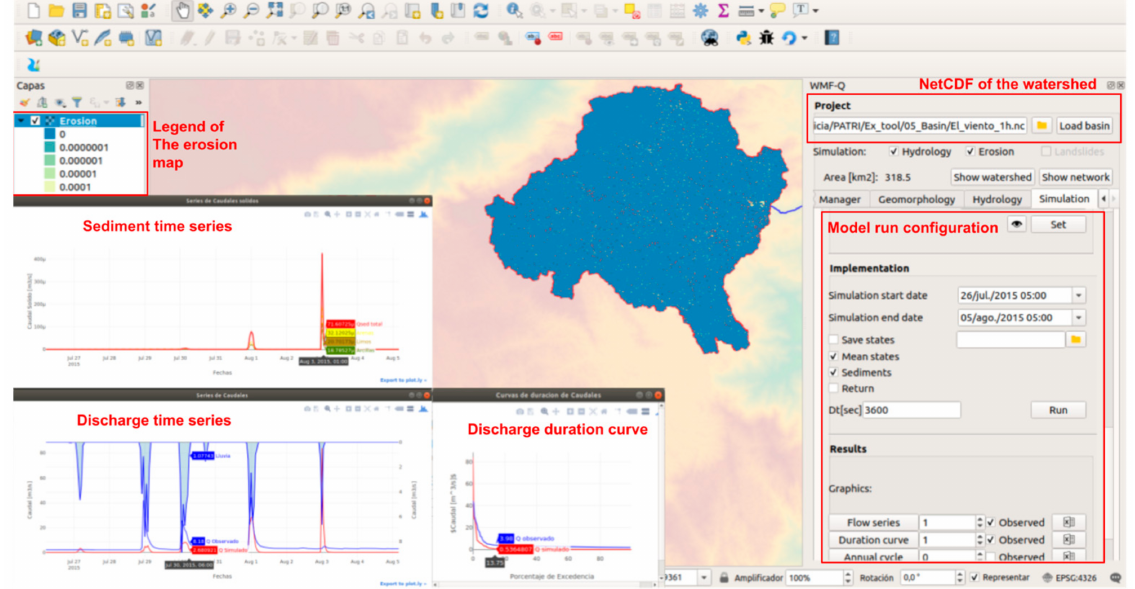
Figure 14. Example of WMF-Q execution simulating discharge and sediment time series. We highlight in red the elements derived from the plugin. The plugin configuration tools are on the right side. The simulated discharge and sediment time series plots are on the left. The watershed divisor and the erosion map are at the center of the